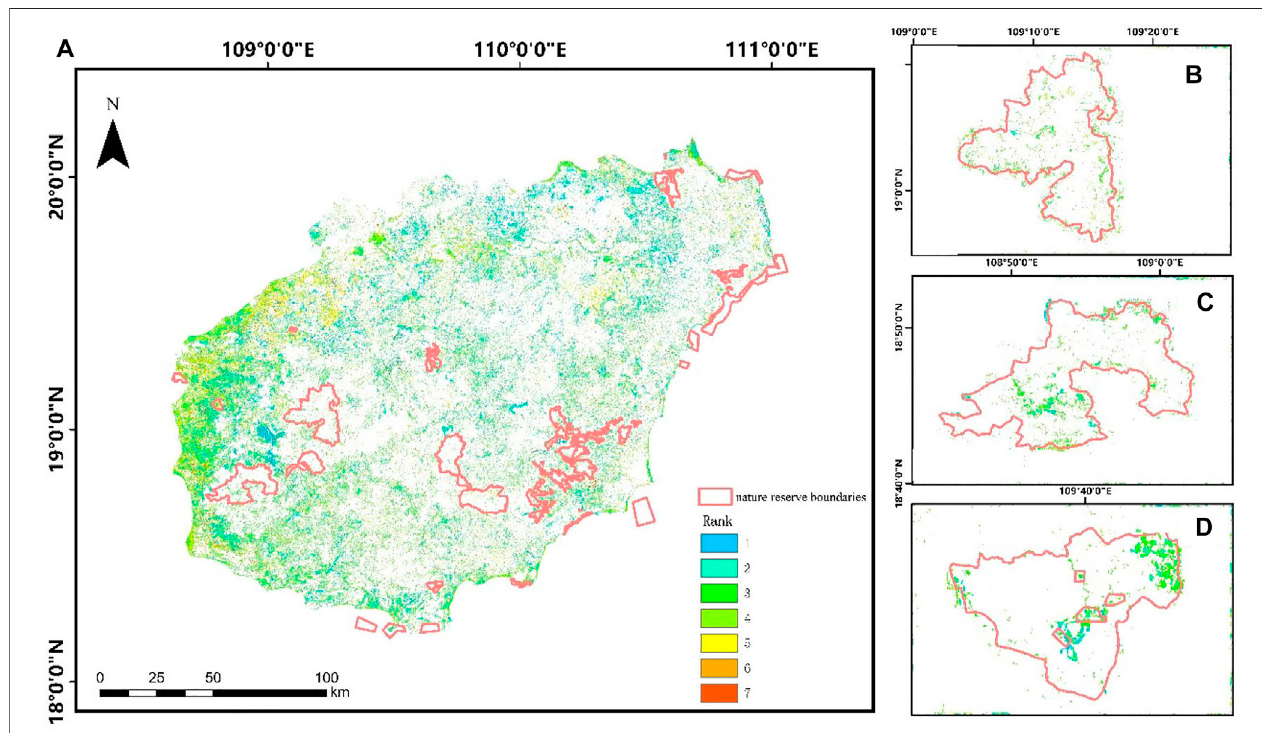
FIGURE 5 | Grade distribution map of forest disturbance intensity in nature reserves. (A) Forest disturbance intensity of the three typical nature reserves in Hainan Island is 2 – 4, 5 is less, and 6 and 7 are the least. (B) Grade distribution map of Bawangling National Nature Reserve. (C) Grade distribution map of Jianfengling National Nature Reserve. (D) Grade distribution map of Ganshiling Provincial Nature